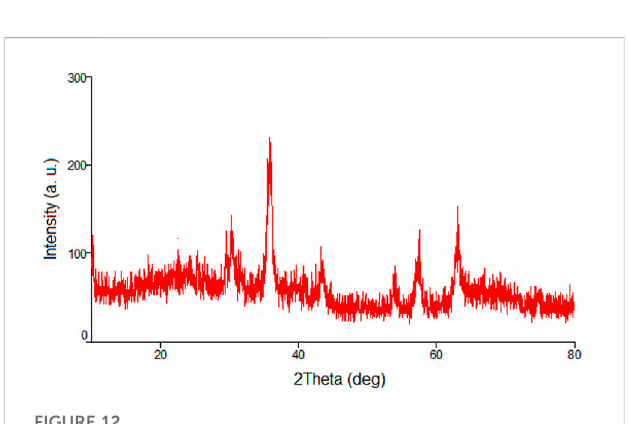
FIGURE 12 The PXRD analysis of the recovered nanocatalyst.